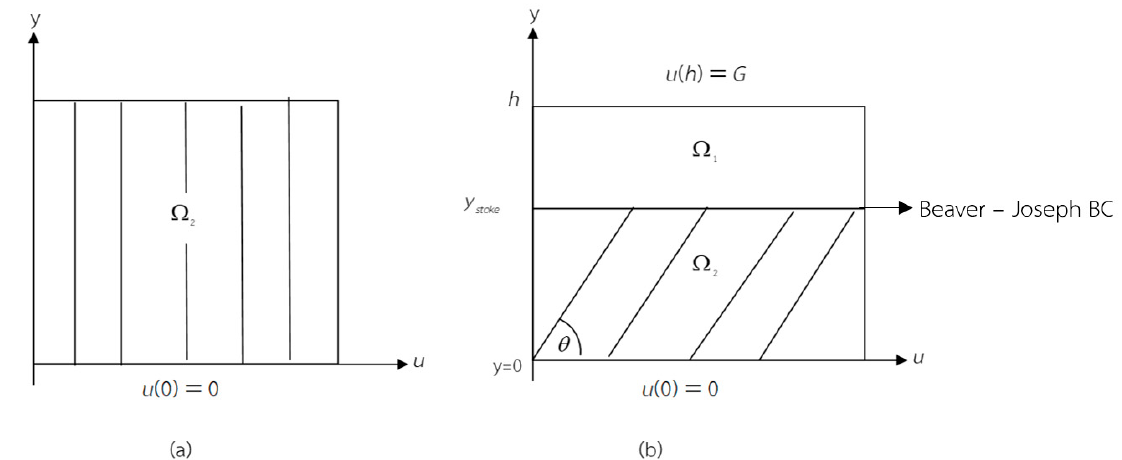
Figure 5. Cilia making the angle θ ,40 ◦ ≤ θ ≤ 90 ◦ , with the horizontal plane. ( a ) cilia are perpendicular to the horizontal plane; ( b ) cilia make angle with the horizontal